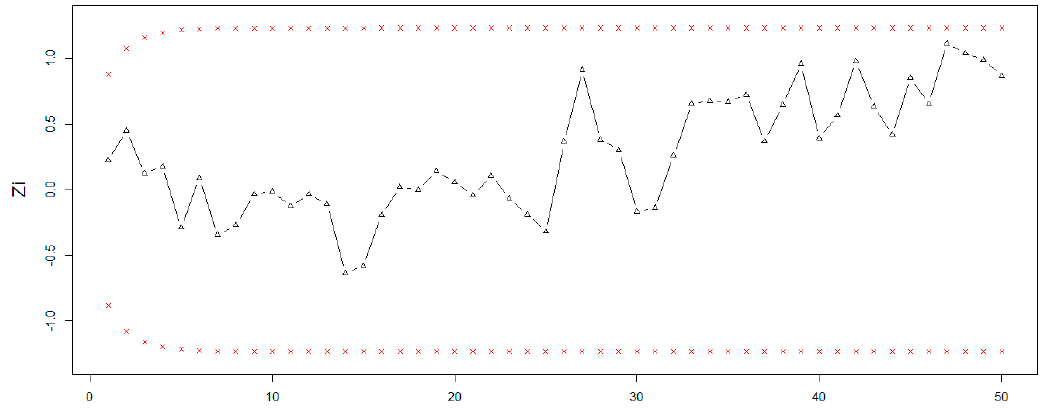
Figure 4. Graph of simulated data of the EWMA control chart when 𝜓 = 0.30, 𝑘 = 2.9355 .